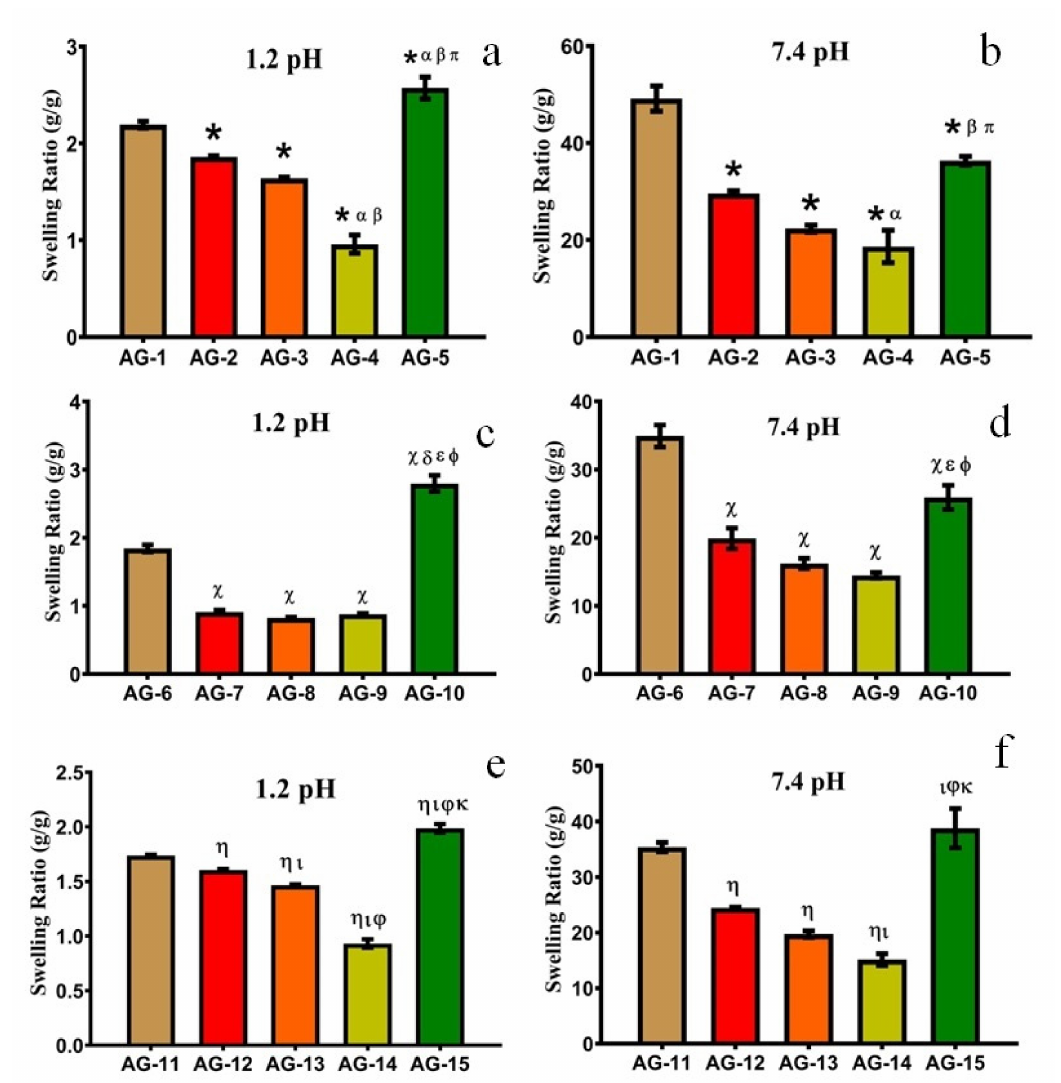
Figure 3. Effect of increasing AA contents on equilibrium SR at pH ( a ) 1.2 and ( b ) 7.4 with constant gelatin (0.33 g). pH ( c ) 1.2 and ( d ) 7.4 with constant gelatin (1.33 g). pH ( e ) 1.2 and ( f ) 7.4, with constant gelatin (2.66 g). All the data are presented as means ± SD ( n = 3). * compared with AG-1, α compared with AG-2. β compared with AG-3, π compared with AG-4, χ compared with AG-6, δ compared with AG-7, ε compared with AG-8, φ compared with AG-9, η compared with AG-11, ι compared with AG-12, ϕ compared with AG-13, κ compared with